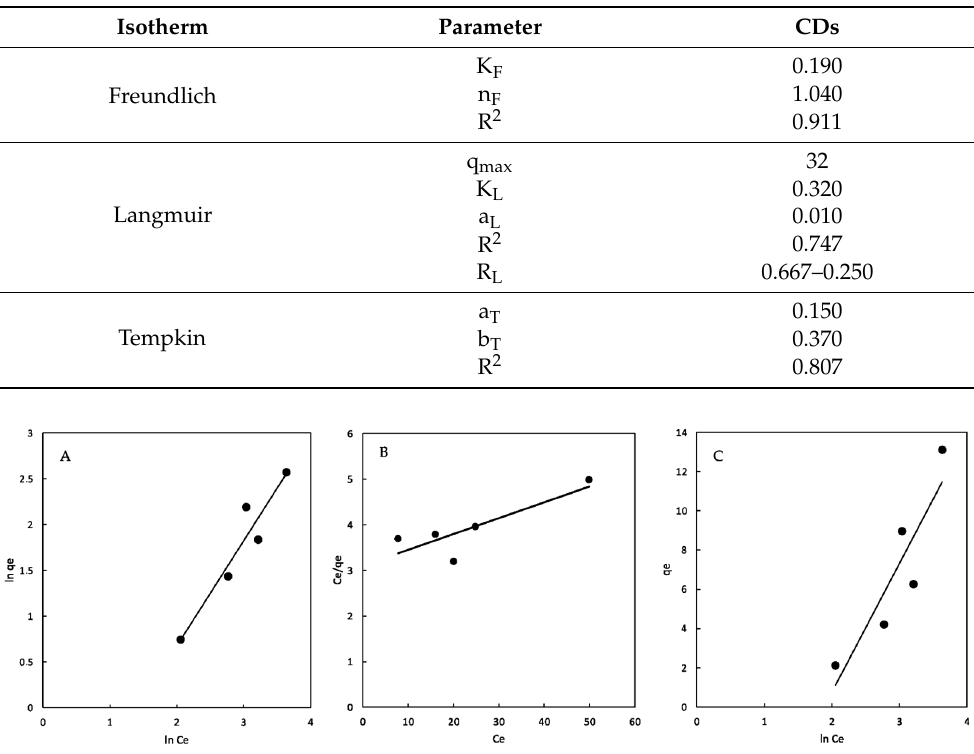
Figure 12. The isotherm analysis. ( A ) Freundlich model; ( B ) Langmuir model; ( C ) Tempkin model.